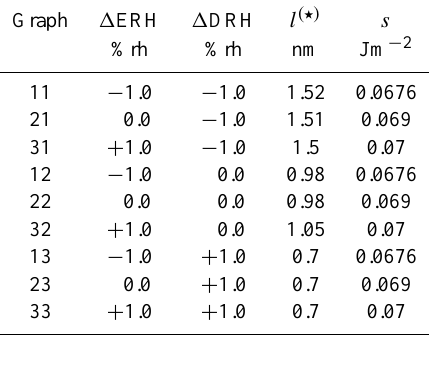
Table 2. Determination of the correlation length l ((cid:63)) according to Eq. (7) for six possible combinations of (cid:49) ERH and (cid:49) DRH values (see Fig. 3). The spreading coefficient s is added.